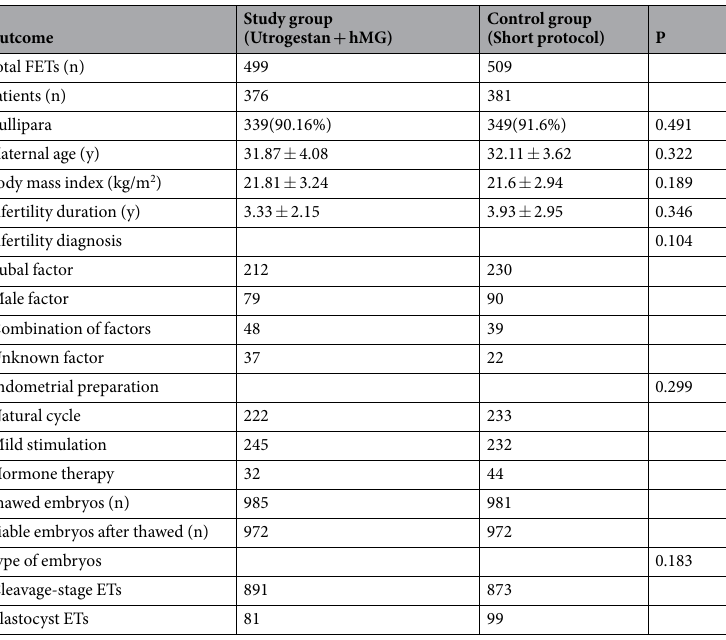
Table 1. Baseline characteristics of sample population stratified by ovarian stimulation